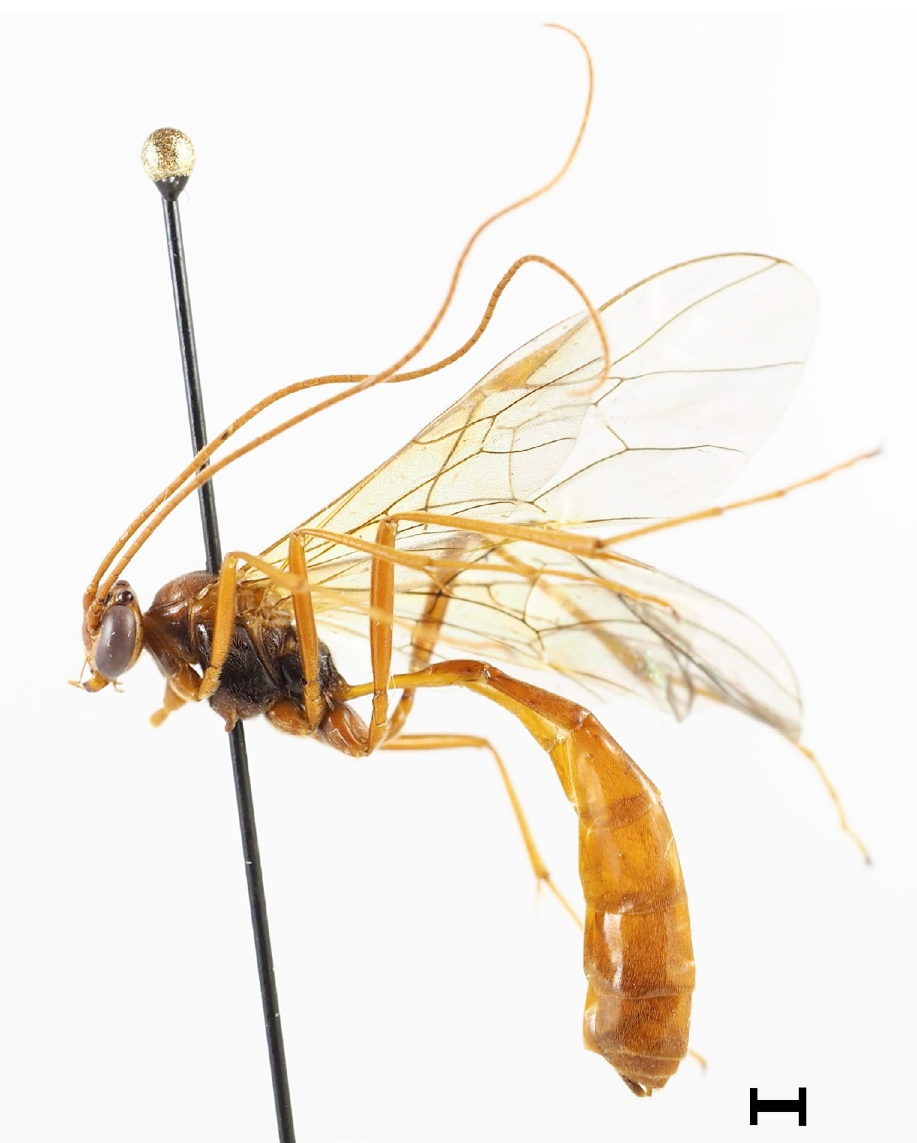
Fig. 40. Ophion pteridis Kriechbaumer, 1879, ♀. Scale bar = 1